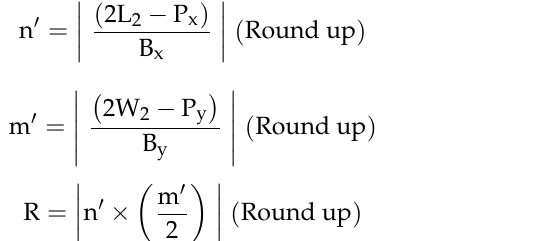
Figure 7. Single object overlap.